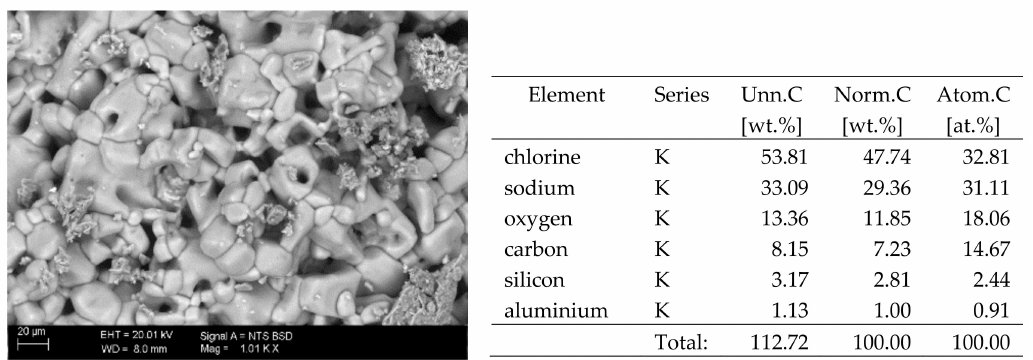
Figure 6. SEM image of the microstructure of NaCl crystals visible on the surface of the bricks tested; 1000 × magnification. Next to it is a screenshot an EDS analysis for presence of